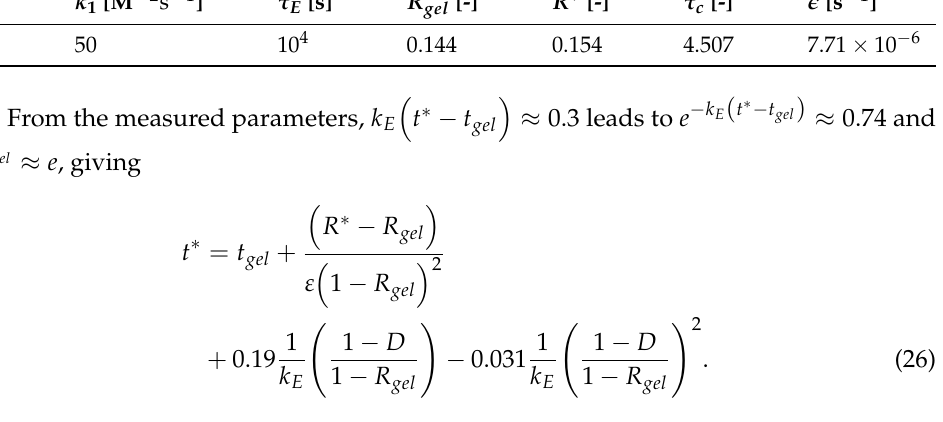
Thus, t ∗ is also linear with C − 2